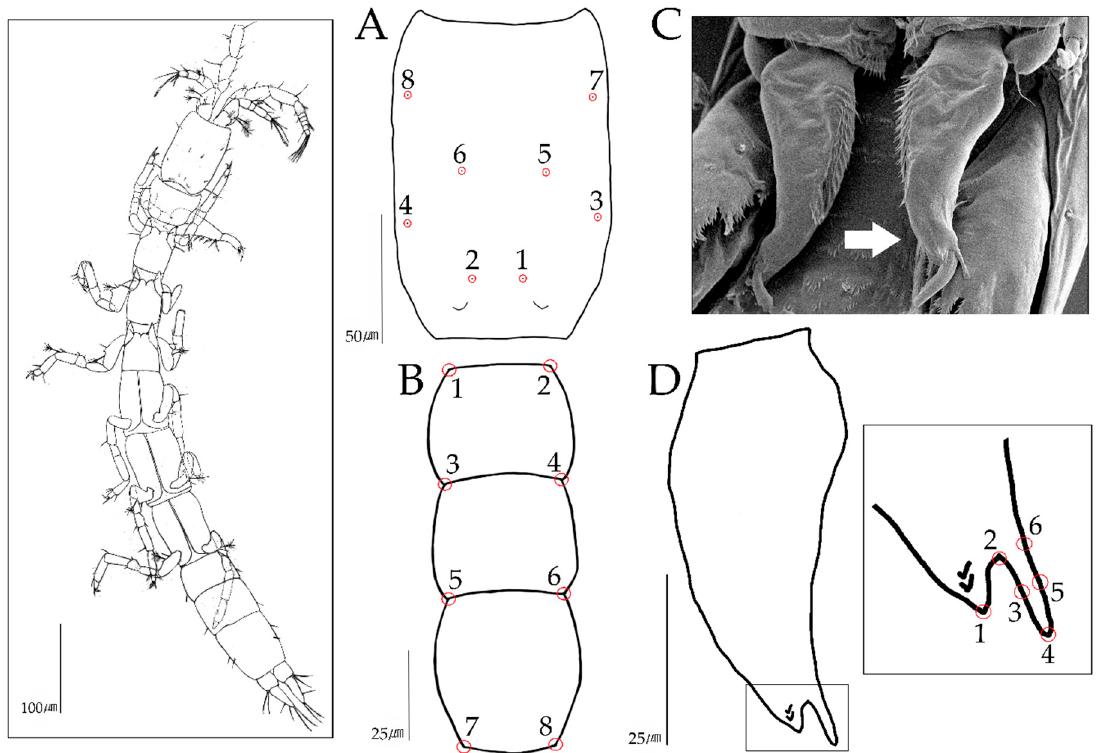
Figure 1. Coxicerberus fukudai digitized pencil drawings. Left panel shows an adult male habitus (NIBRIV0000000000), scale bar: 100 µ m. ( A ) Dorsal view of cephalothorax, sensilla distributions are marked with red circles, scale bar: 50 µ m; ( B ) dorsal view of pleon, pleonal points are marked with red circles, scale bar: 50 μ m; ( C ) scanning electron microscope image of pleon, white arrow indicates pleopod II endopodite; ( D ) pleopod II endopodite excluding appendix masculina pencil image, right panel shows close up image of digitizing points with red marks.